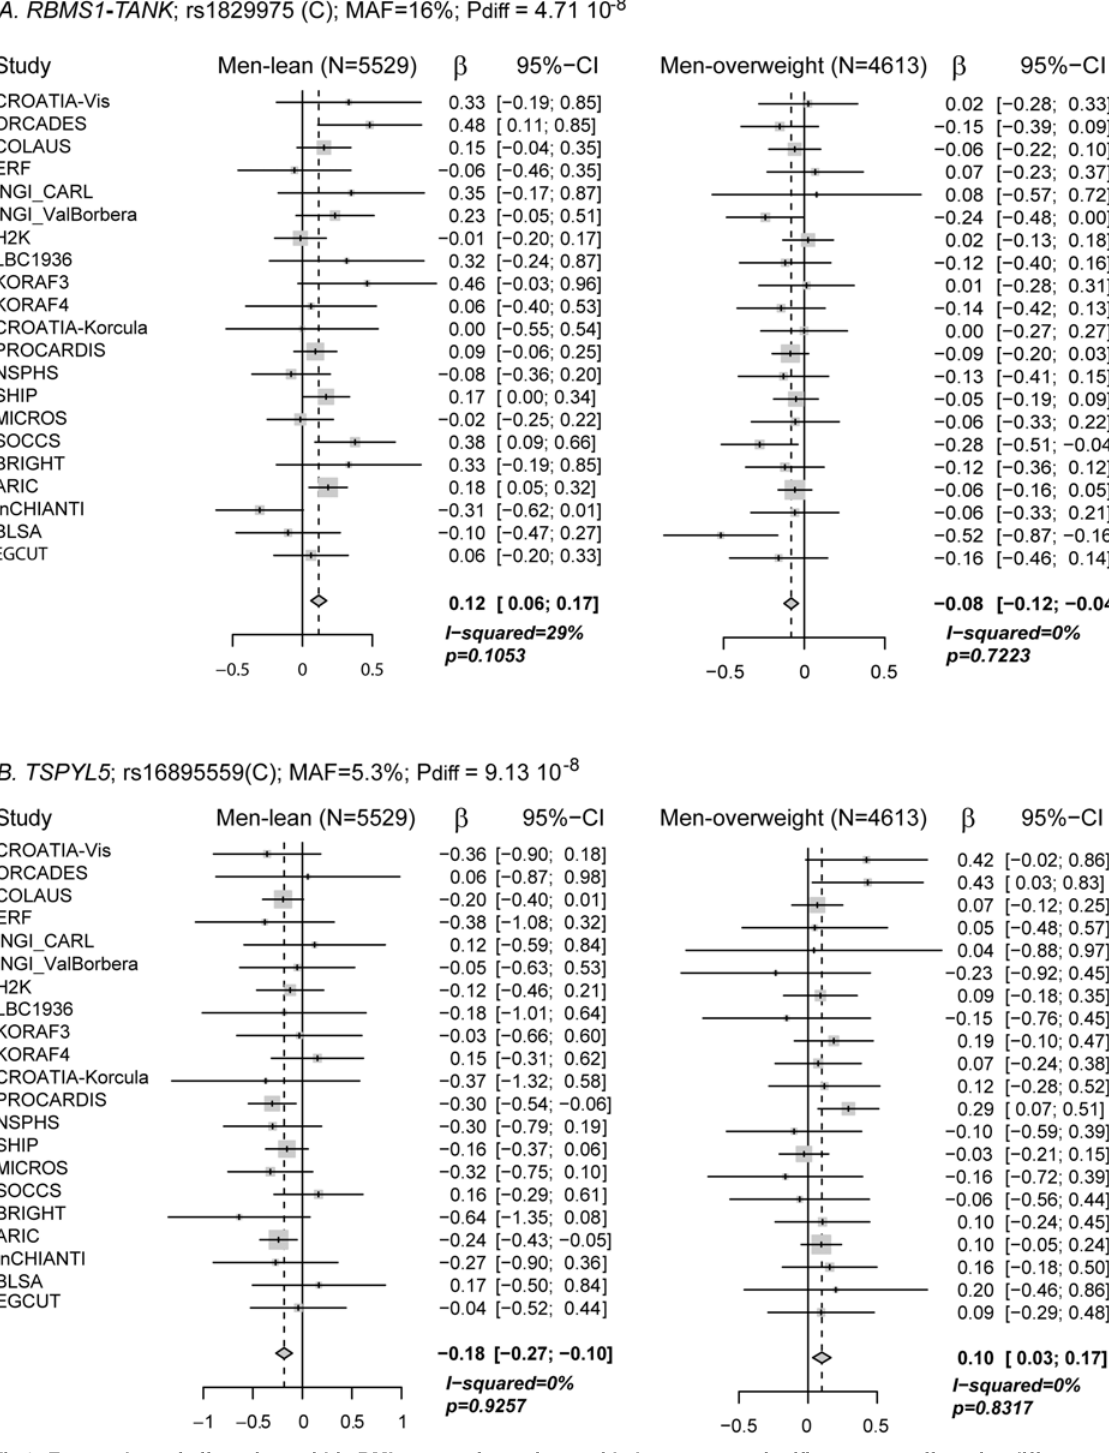
PLOS ONE | DOI:10.1371/journal.pone.0119752 March 26,